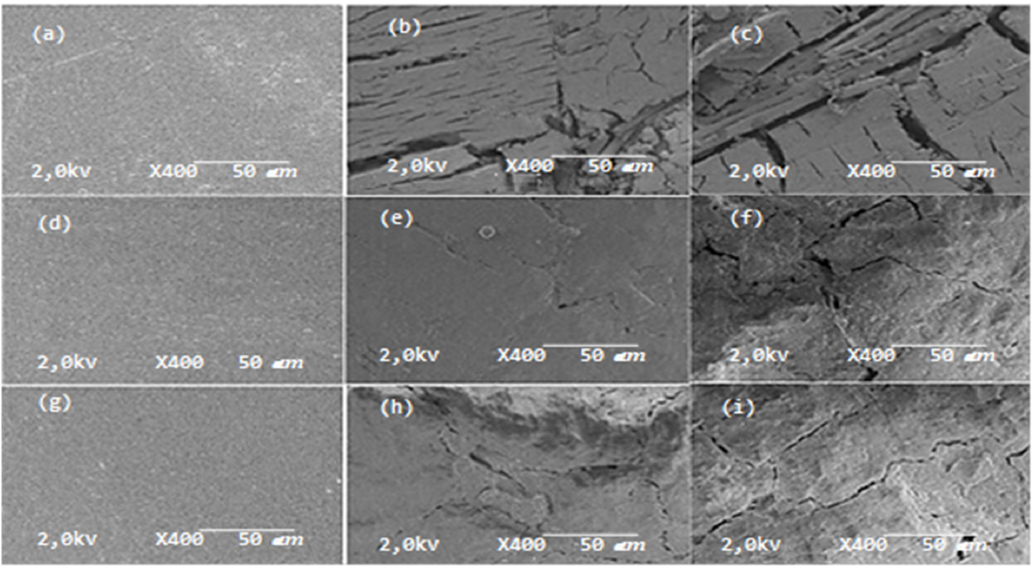
Figure 6. ( a ) PP / BF t = 0 m; ( b ) PP / BF t = 6 m; ( c ) PP / BF t = 12 m; ( d ) PP / BF / MA t = 0 m; ( e ) PP / BF / MA t Figure 6. ( a ) PP/BF t = 0 m; ( b ) PP/BF t = 6 m; ( c ) PP/BF t = 12 m; ( d ) PP/BF/MA t = 0 m; ( e ) PP/BF/MA = 6 m; ( f ) PP / BF / MA t = 12 m; ( g ) PP / BF / CI t = 0 m; ( h ) PP / BF / CI t = 6 m; ( i ) PP / BF / CI t = 12 t = 6 m; ( f ) PP/BF/MA t = 12 m; ( g ) PP/BF/CI t = 0 m; ( h ) PP/BF/CI t = 6 m; ( i ) PP/BF/CI t = 12 m.